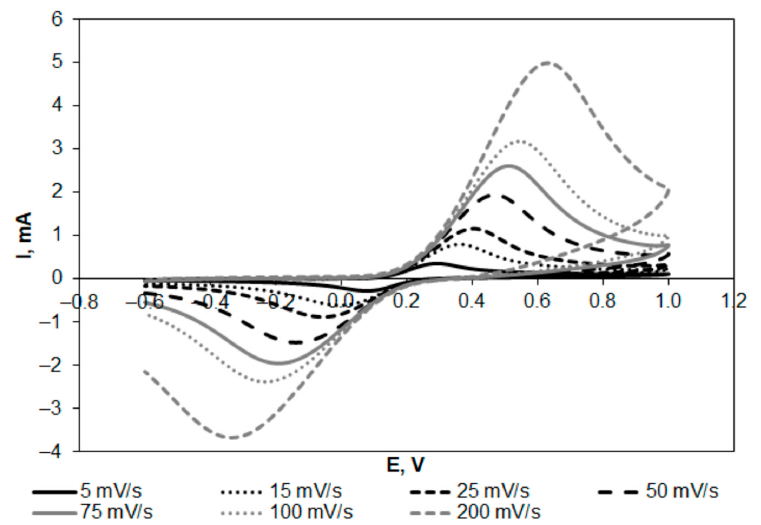
Figure 4. Exemplary cyclic voltammograms recorded at GFA electrodes in K 4 [Fe(CN) 6 ] (5 × 10 − 3 mol L − 1 in 0.1 mol L − 1 KCl) at the scan rates in the range from 5 to 200 mV s − 1 . Electrochemical parameters, i.e., peak current, peak potential, a ratio of anodic peak current to cathodic peak current, difference between anodic and cathodic peak potential, and half-wave potential, determined from cyclic voltammetry curves, are listed in Table 2. Table 2. CV parameters determined from cyclic voltammograms recorded in K 4 [Fe(CN) 6 ] (5 × 10 − 3 mol L − 1 in 0.1 mol L − 1 KCl) at the scan rate of 5 mV s − 1 . GFA Material